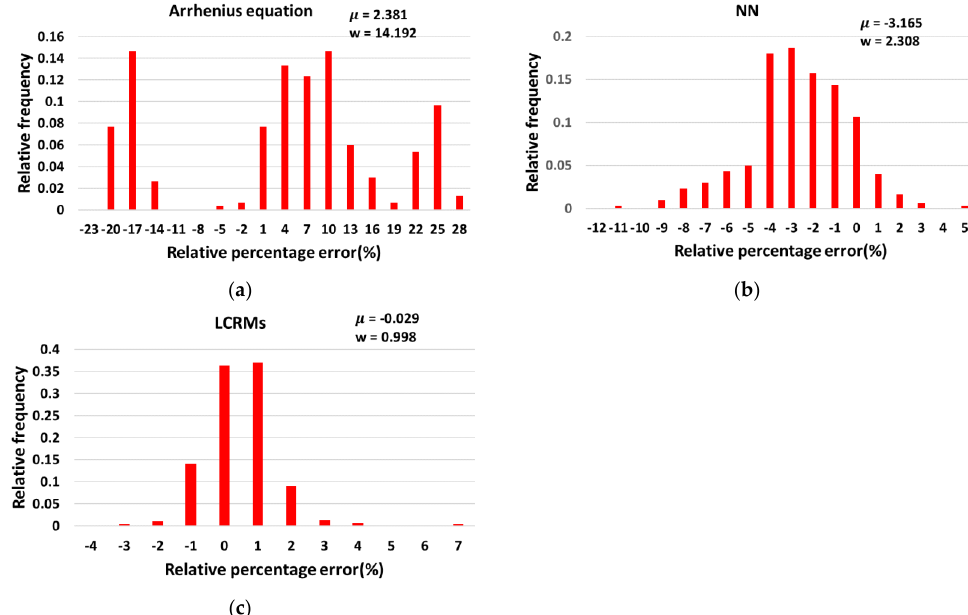
Figure 9. Relative percentage error by ( a ) Arrhenius equation, ( b ) NN, and ( c ) LCRMs.